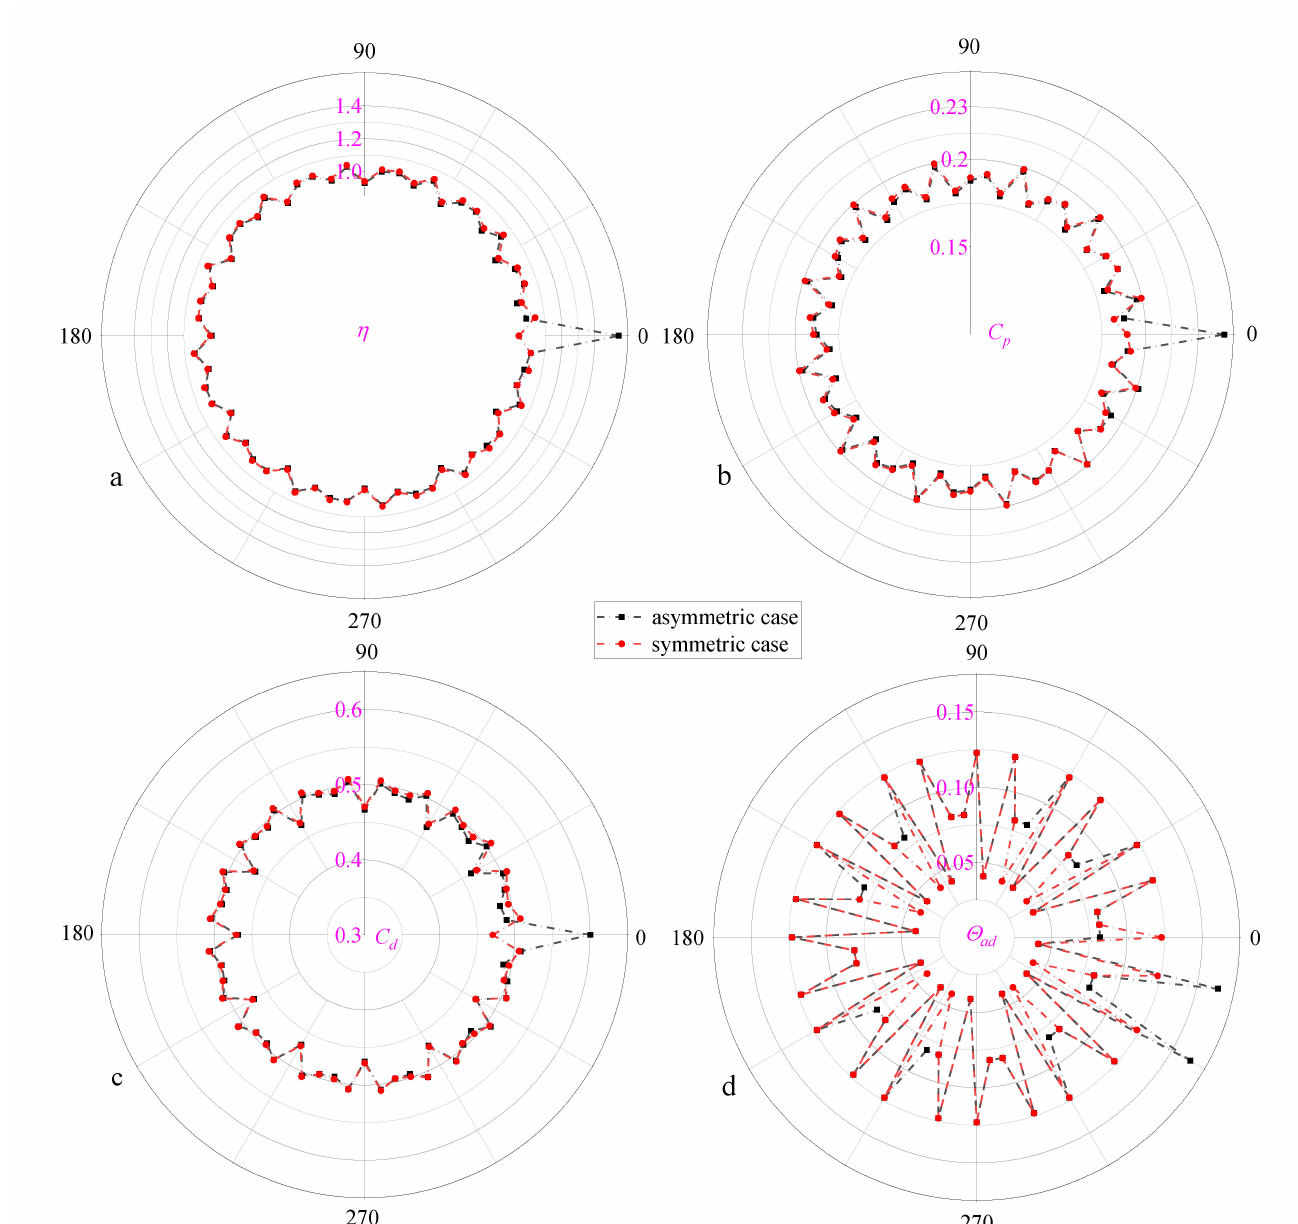
Figure 9. Distribution of ( a ) mass-flow-rate ratio η , ( b ) total-pressure-loss coefficient C p , ( c ) discharge coefficient of holes C d , and ( d ) adiabatic effectiveness Θ ad for symmetric and asymmetric boundary conditions when α = 70 ◦